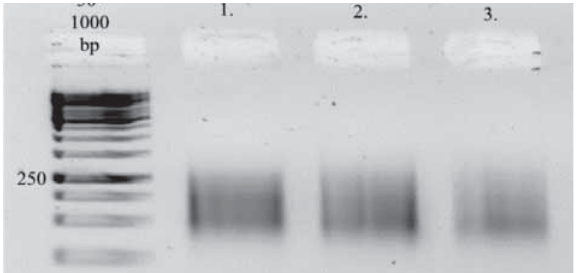
Figure 2. Electrophoretic gel photo of the PCR products after the digestion with Tru1I restriction endonuclease followed by adaptor ligation. First lane is 50 bp Gene Ruler (Fermentas, Biocenter, Hungary). 1-3 lanes mean different amount of template DNA: 0.75 μl, 1.5 μl and 2.5 μl. As a result, many, different fragments were amplified. The work was continued with the second sample.